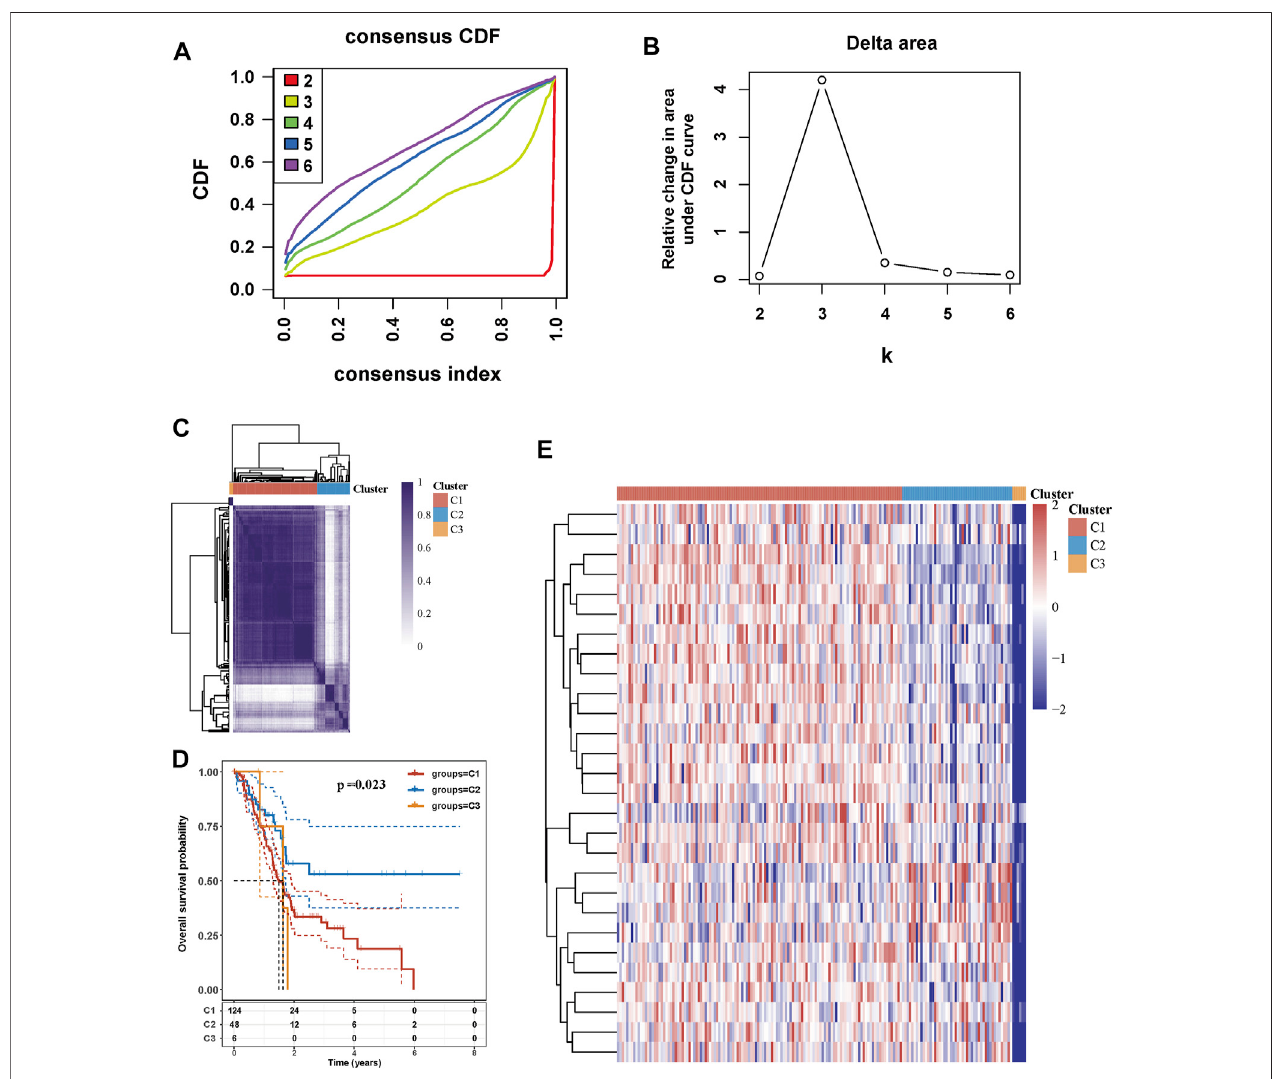
FIGURE2| Tumor classi fi cation basedon mitophagy-related genes (A) Cumulative distribution function (CDF) curves (B) Delta area curve ofconsensus clustering (C) Consensus clustering matrix (K = 3) (D) Kaplan-Meier survival analysis of the three subgroups (E) Heatmap of mitophagy-related gene expression in the three